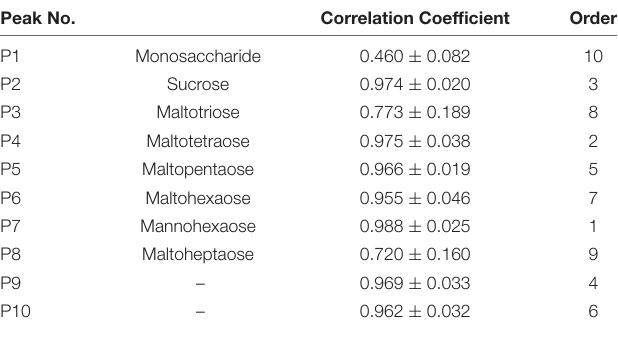
concentration gradients (400, 200, 100, 50, 25 µ g/mL), the secretion of NO was measured with Griess